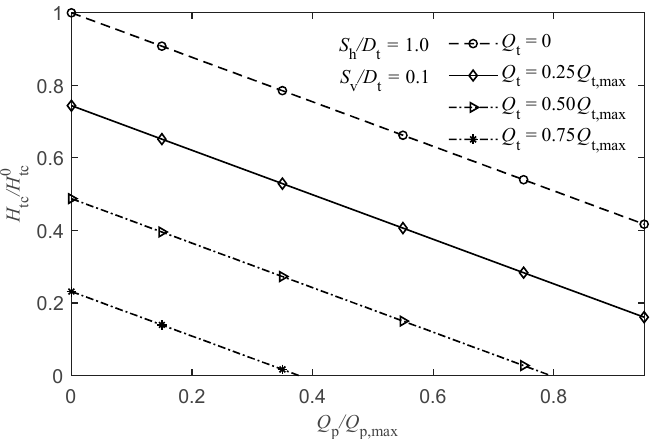
Figure 15. Relative pressure head of the tunnel crown versus drainage volume of the parallel adit.